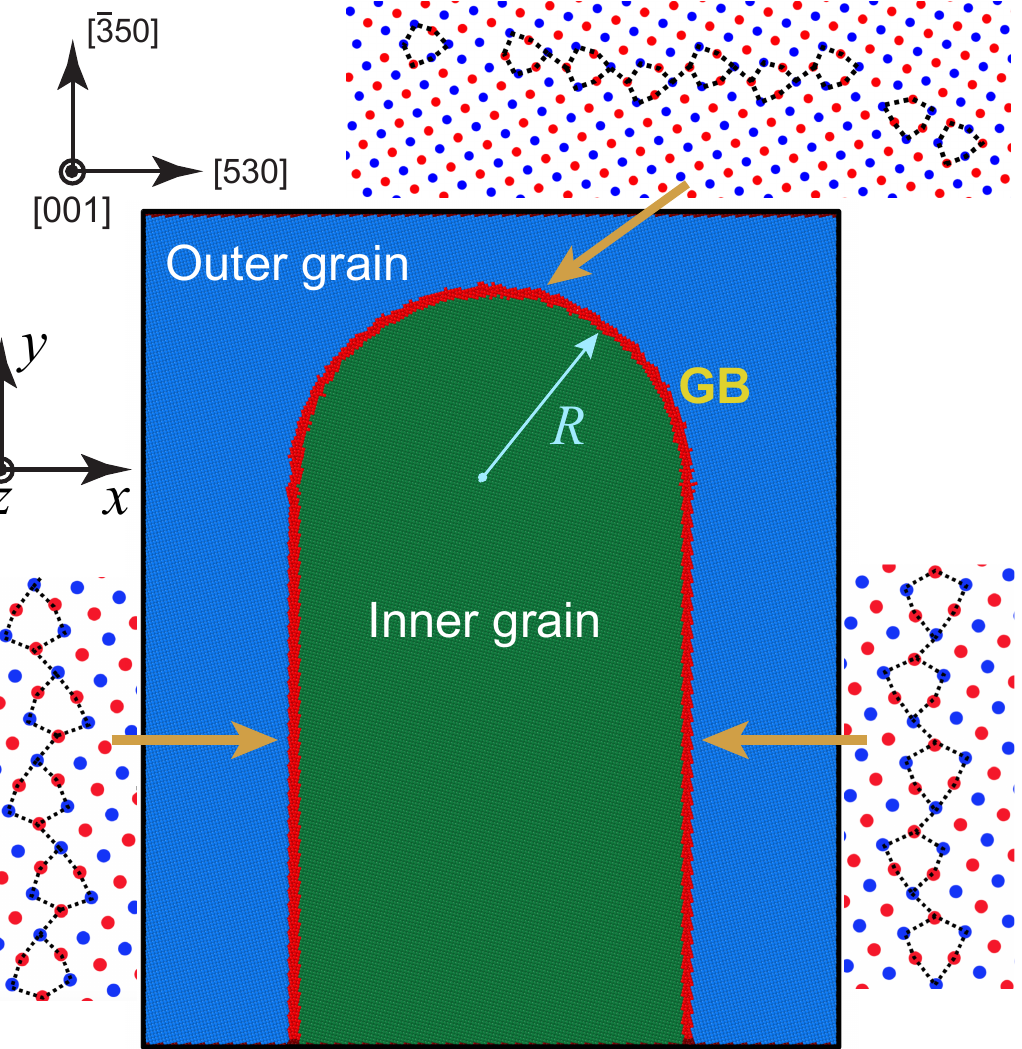
Figure 2. Cu bicrystal with a half-loop GB studied in this work. The GB crystallography is Σ 17[001] with symmetrical tilt inclinations along the vertical portions and at the tip point and asymmetrical tilt inclinations along other curved surfaces. The kite-shaped structural units of the GB structure are outlined. The atoms of the outer and inner grains are shown in blue and green, respectively, with the GB atoms shown in